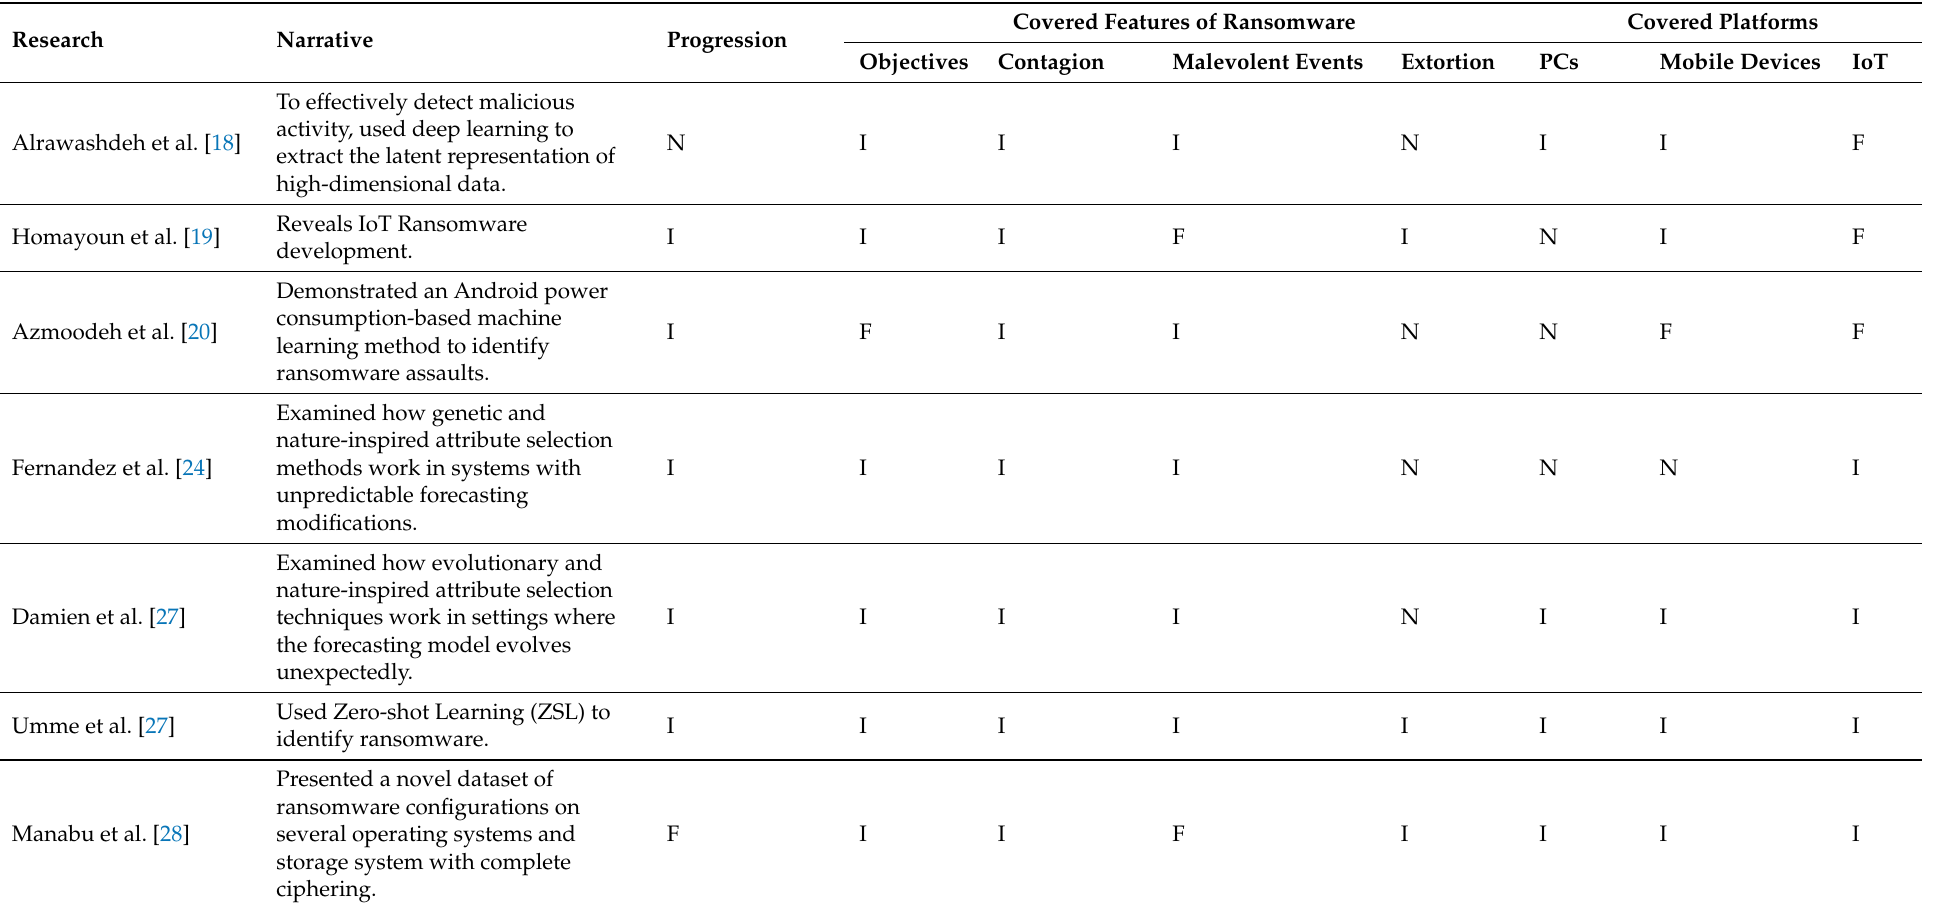
Table 1. Assessment of similarities and differences of Related